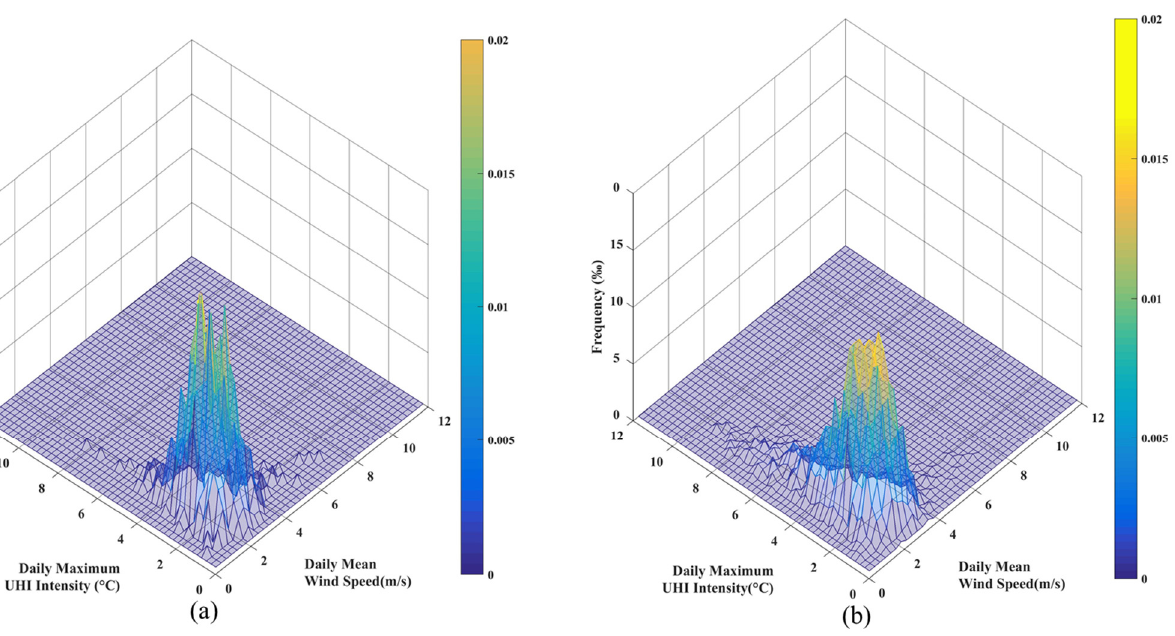
Figure 5. Frequency distribution of UHImax as a function of wind speed (2002–2012, ( a ) summer, ( b )